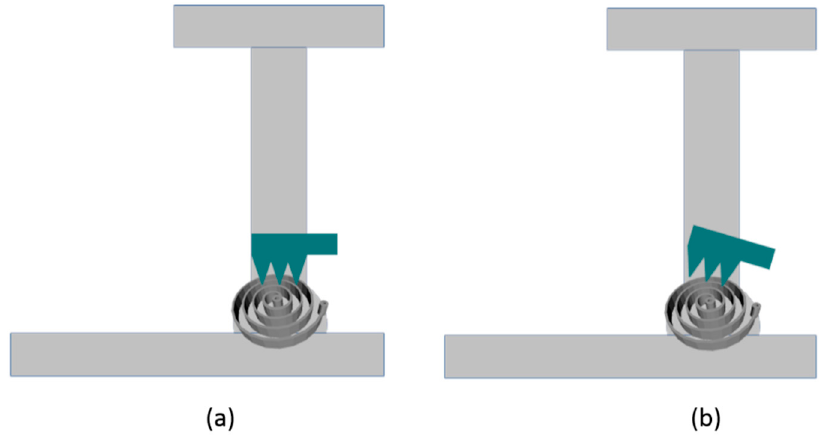
Figure 8. Adjust by Wilk. ( a ) Locked position; ( b ) release position [32].